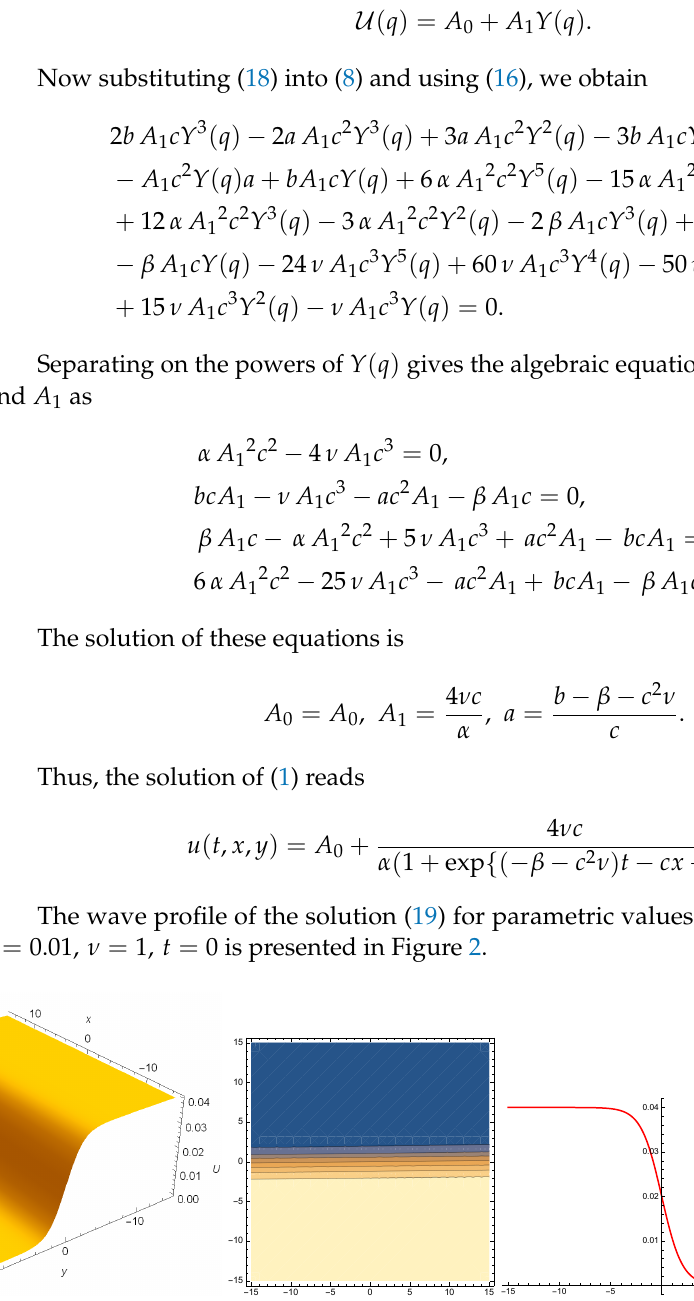
Figure 2. The 3D and 2D solution profile of